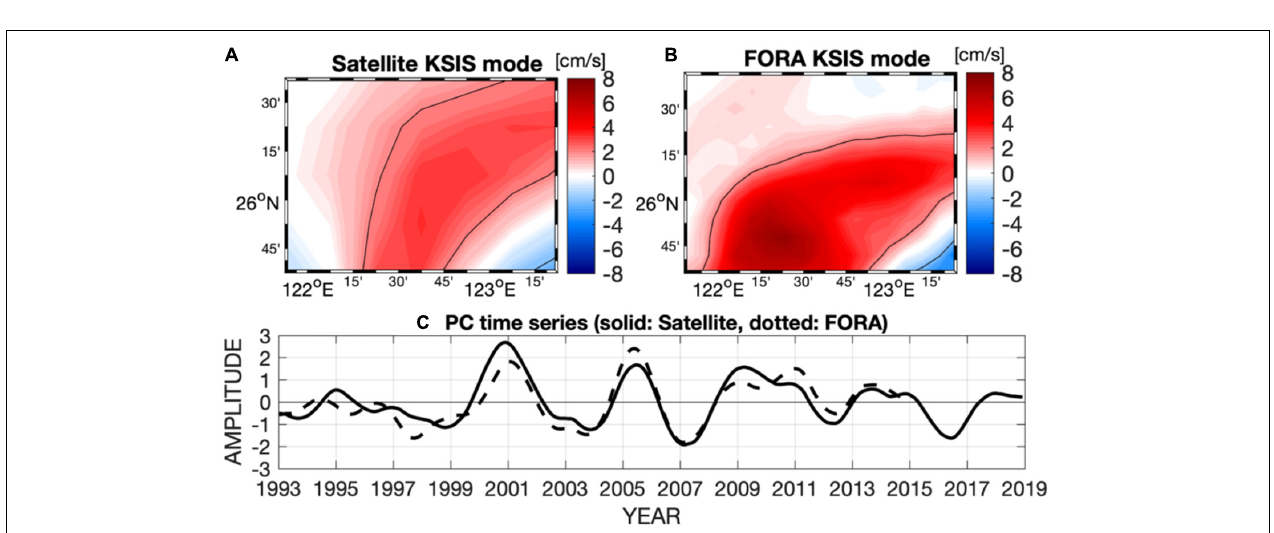
FIGURE 2 | R -squared values of the regression analysis of (A) speed and (B) temperature at each depth targeting the KSI strength mode from FORA. Regression anomalies at the depths with red dots are presented in Figures 5 , 6 .